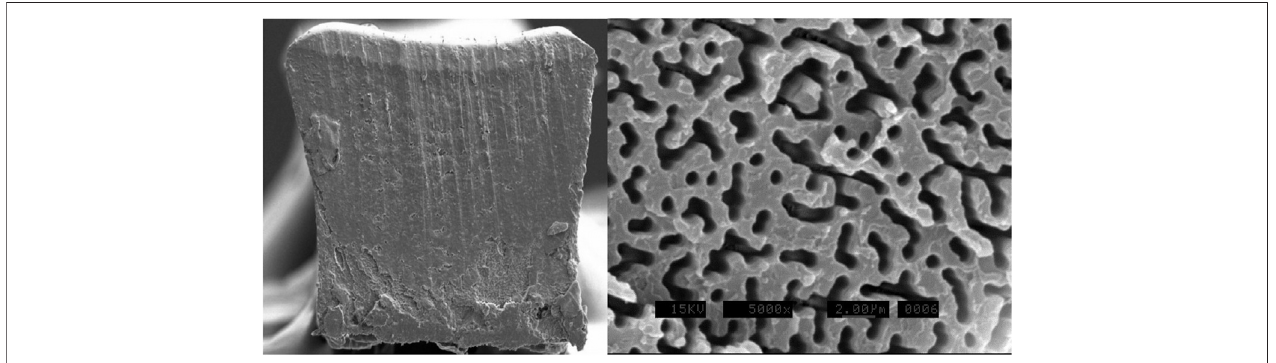
FIGURE 6 | In the left panel, we show the cross-section of the polymer disordered fi ber from Ref. [1], which has a nearly square pro fi le with an approximate side- width of 250 µm. In the right panel, we show the zoomed-in SEM image of a 24 µm-wide region on the tip of the fi ber. For this picture, to enhance the contrast between PMMA and PS, the PMMA near the surface of the tip has been etched by a solvent. Feature sizes are around 0.9 µm, and darker regions are PMMA. Reprinted/ Reproduced with permission from Optics Letters, 2012 [1], and the Optical Society of America.